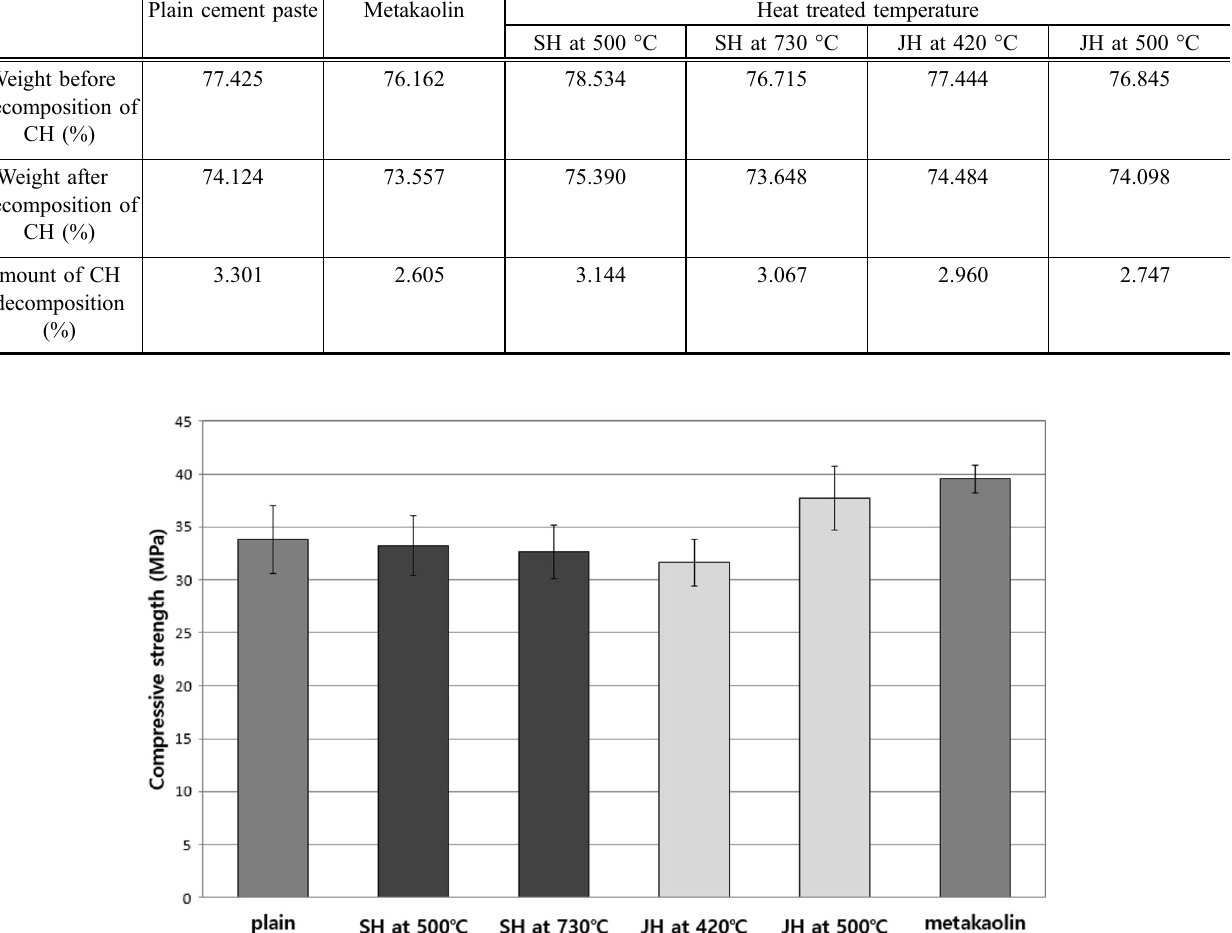
Fig. 10 Compressive strength of 28 day old cement mortar (w/b = 0.5) with 10% replacement of heat treated dredged sea